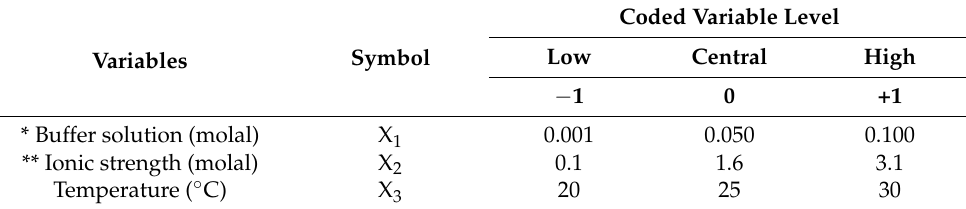
Table 1. Levels of variables chosen for BBD.